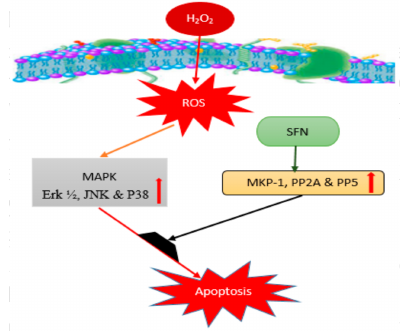
Figure 3. MAPK pathway for neuroprotective effect of sulforaphane: Involving extracellular signal regulated protein kinase 1 (Erk 1 ), C-Jun N-terminal kinase (JNK), P38, MAPK phosphatase (MKP-1), 2 2 serine/threonine protein phosphatase 2A (PP2A), Protein Phosphatase 5 (PP5). SFN: sulforaphane; ROS: reactive oxygen